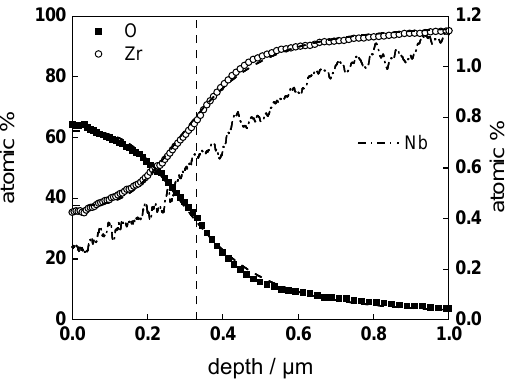
Figure 6. Elemental composition profile of the oxide formed for 24 ( a ) and 720 h ( b ) in WWER coolant without LiOH at 300 °C. Dashed lines show sigmoidal regression of O and Zr profiles to estimate the position of the alloy/oxide interface (shown by vertical line).